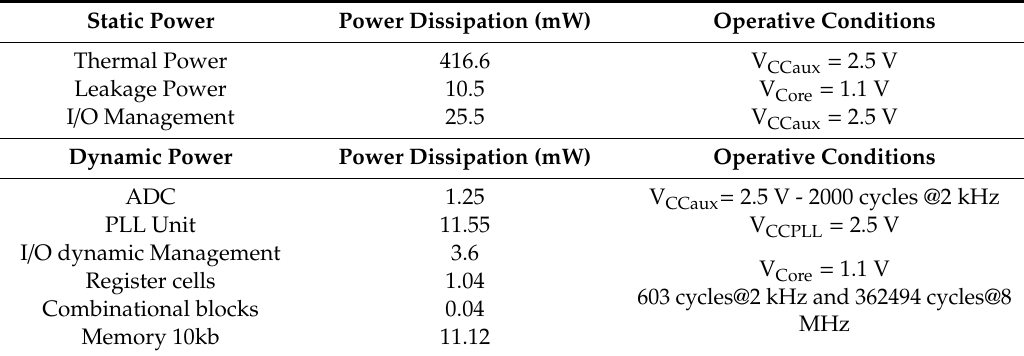
Table 4. Power Consumption Features.